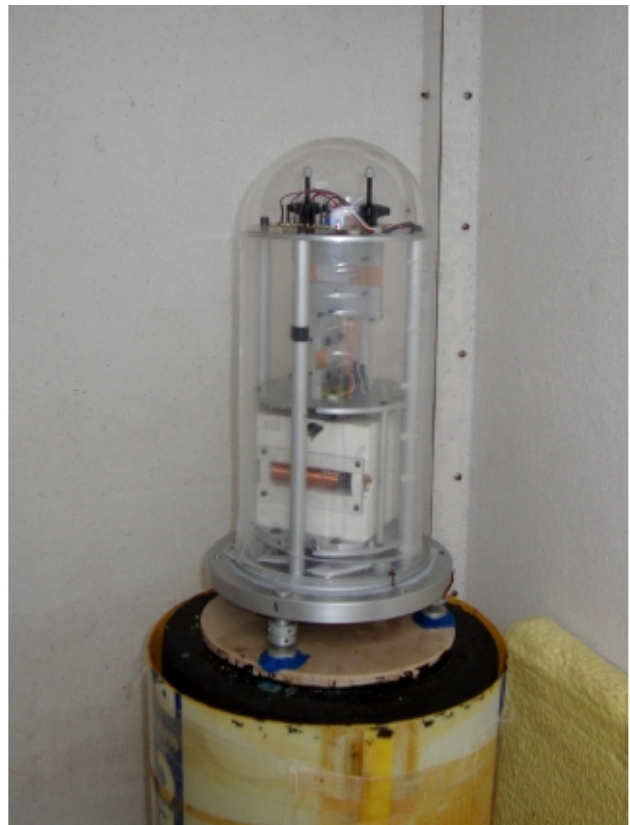
Figure 4. The three-axis automatic fluxgate magnetometer was added in 2008. More